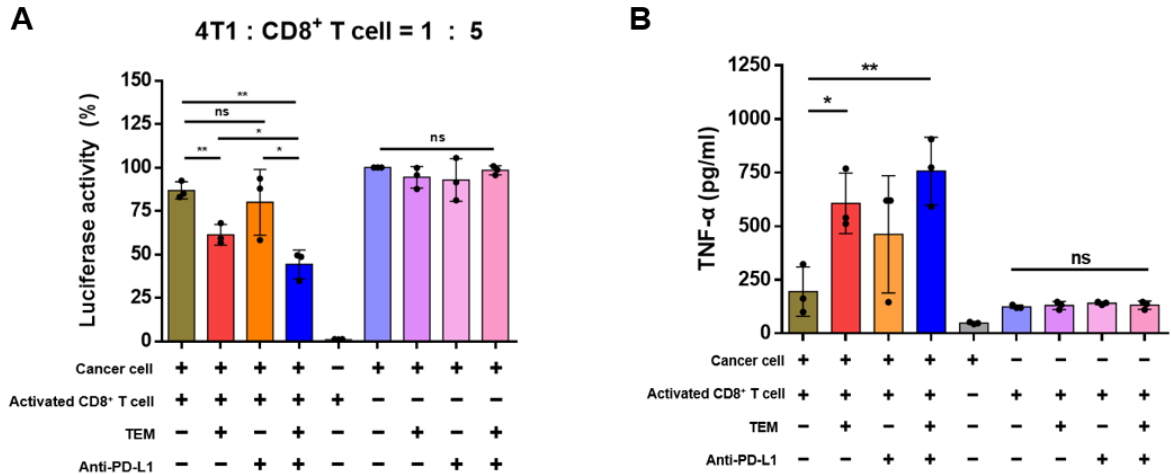
Figure 3. Temsirolimus (TEM) promotes CD8 + T cell-mediated anti-cancer immunity. ( A ) The murine CD8 + T cell-mediated cancer killing effect in the 4T1-luciferase cells after indicated treatments ( n = 3). ( B ) Cytokine levels of TNF- α in the supernatant after co-culture with CD8 + T cells and cancer cells or in the supernatant of each cell alone were quantified using enzyme-linked immunosorbent assay (ELISA) ( n = 3). The data are presented as means ± standard deviation (SD) using an unpaired two-tailed Student’s t -test. * p < 0.05, ** p < 0.01, respectively; ns, not significant.